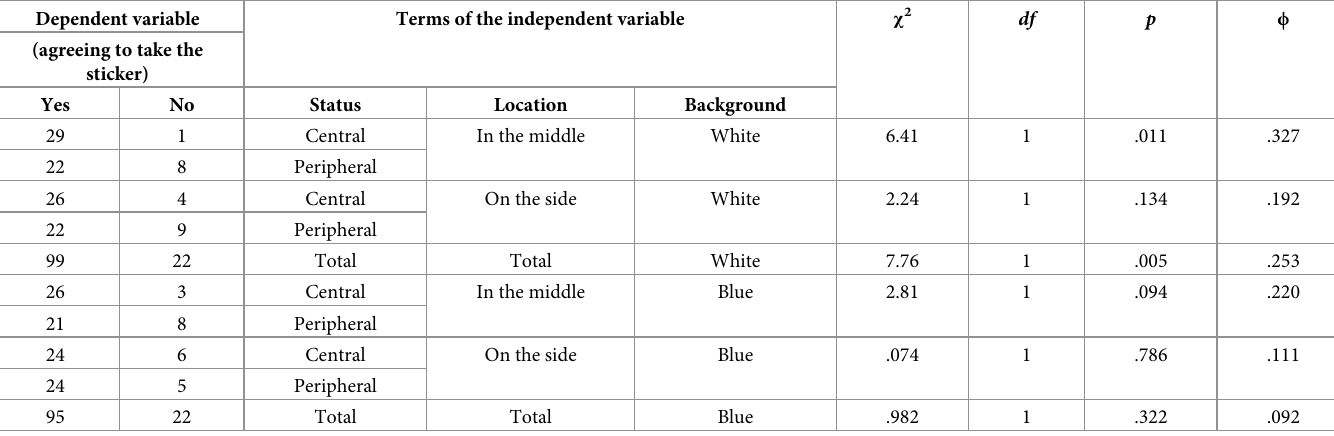
Table 6. Effects of Status x Location x Background interaction on first target behavior (summary of chi-square tests). Dependent